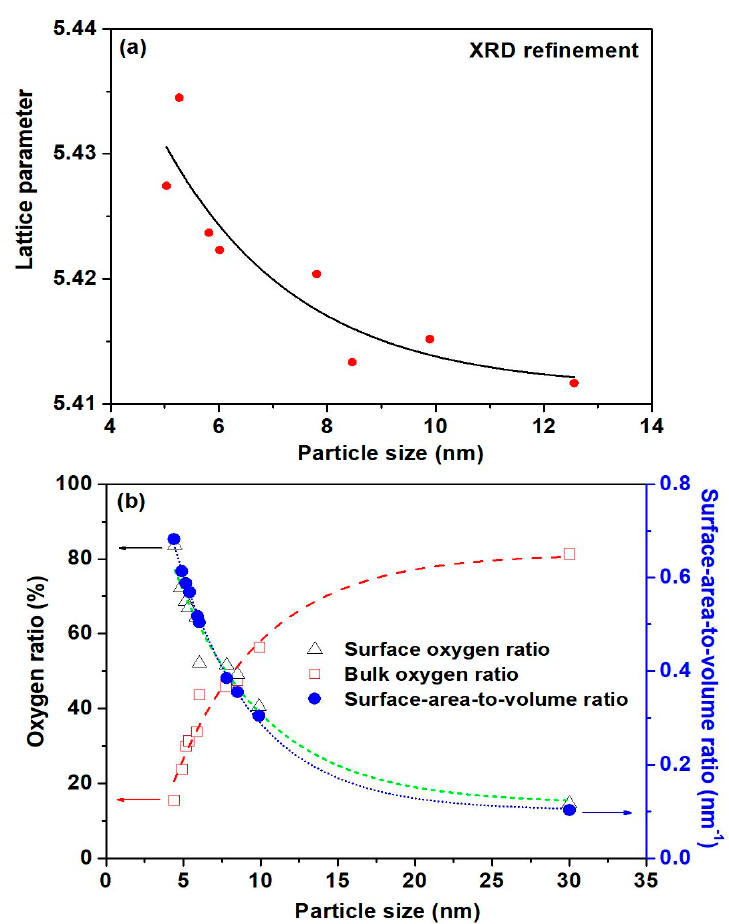
Figure 5. ( a ) Lattice expansion of ceria as a function of size and ( b ) the inverse relationship of surface oxygen to bulk oxygen (TPR) and the correlation of surface oxygen ratio with the theoretical surface to volume ratio. Adapted from Reference [71]. Copyright © 2010, Royal Society of Chemistry.